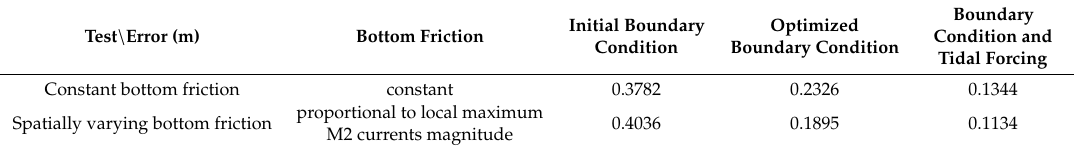
proportional to local maximum M2 currents